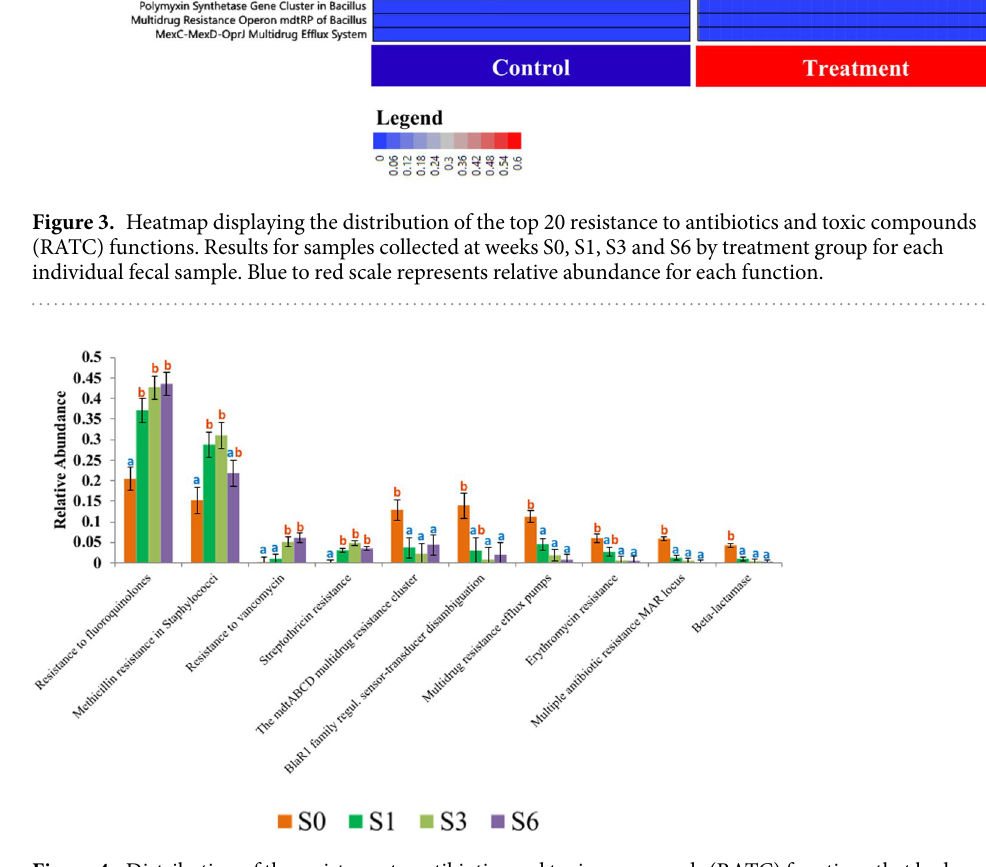
Figure 4. Distribution of the resistance to antibiotics and toxic compounds (RATC) functions that had significantly different relative abundance at different weeks. Results for samples collected at weeks S0, S1, S3 and S6. Different letters indicate time points that were significantly different based on pairwise analysis for each